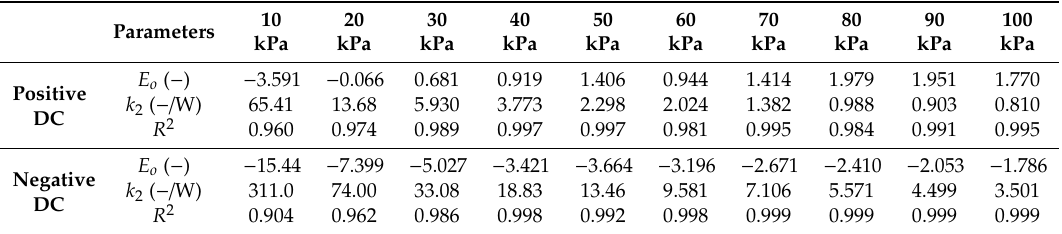
Table 2. DC supply. Main parameters of the linear regression between the energy of the images and the power dissipated by the PDs ( E images = E o + k 2 · P PD